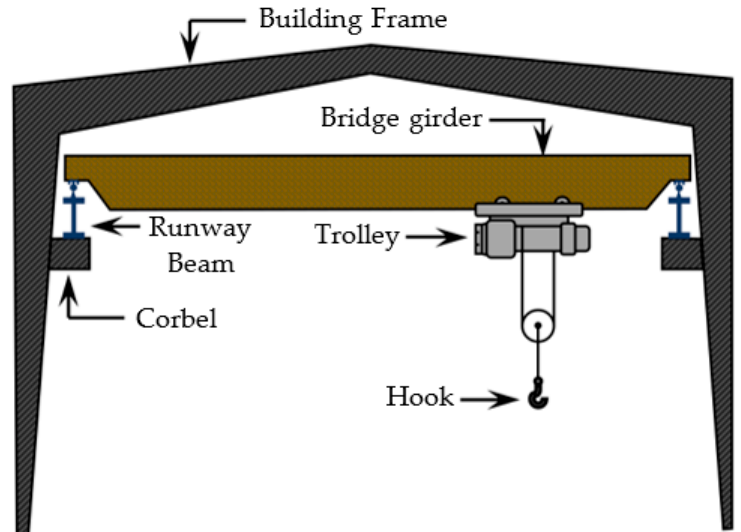
Figure 2. Typical details of a top running bridge crane with a suspended trolley.